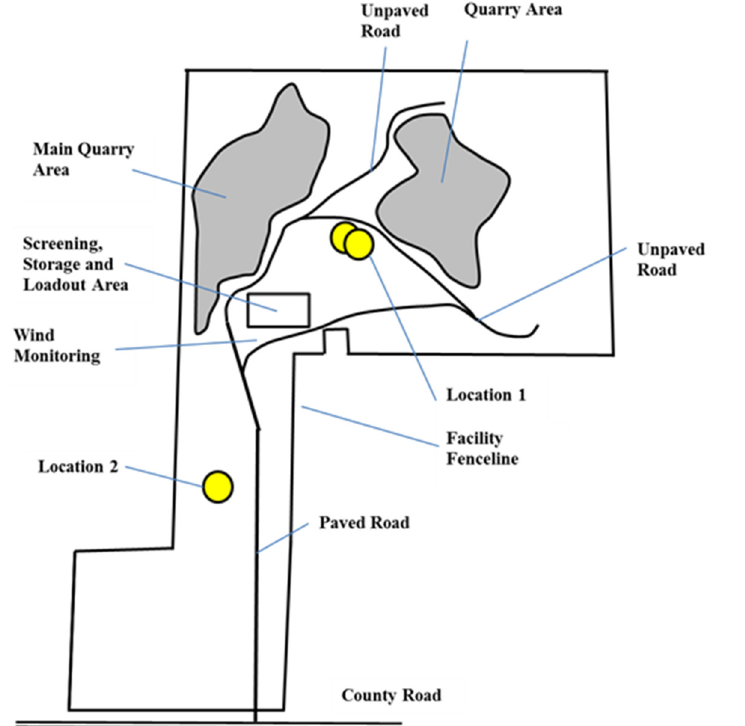
Figure 3. DS Mine sampler locations.